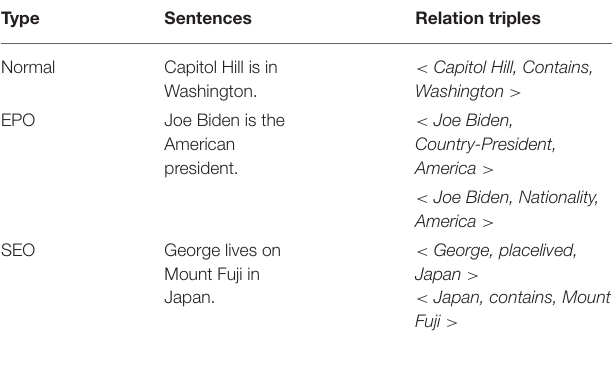
TABLE 1 | Examples of sentence types, normal, EPO, and